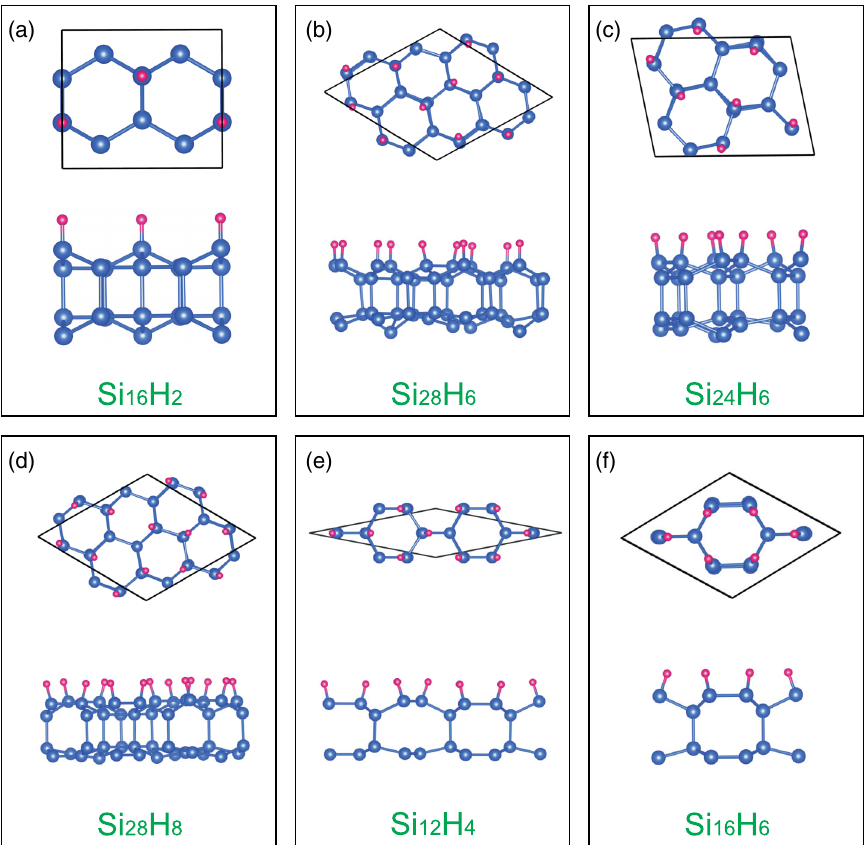
FIG. 3. The top and side views of six CE-discovered intermediate ground-state structures for single-sided (a) Si 16 H 2 , (b) Si 28 H 6 , (c) Si 24 H 6 , (d) Si 28 H 8 , (e) Si 12 H 4 , and (f) Si 16 H 6